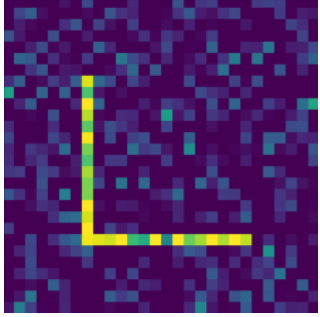
Figure 24. Mirrored object, with level 2 noise.